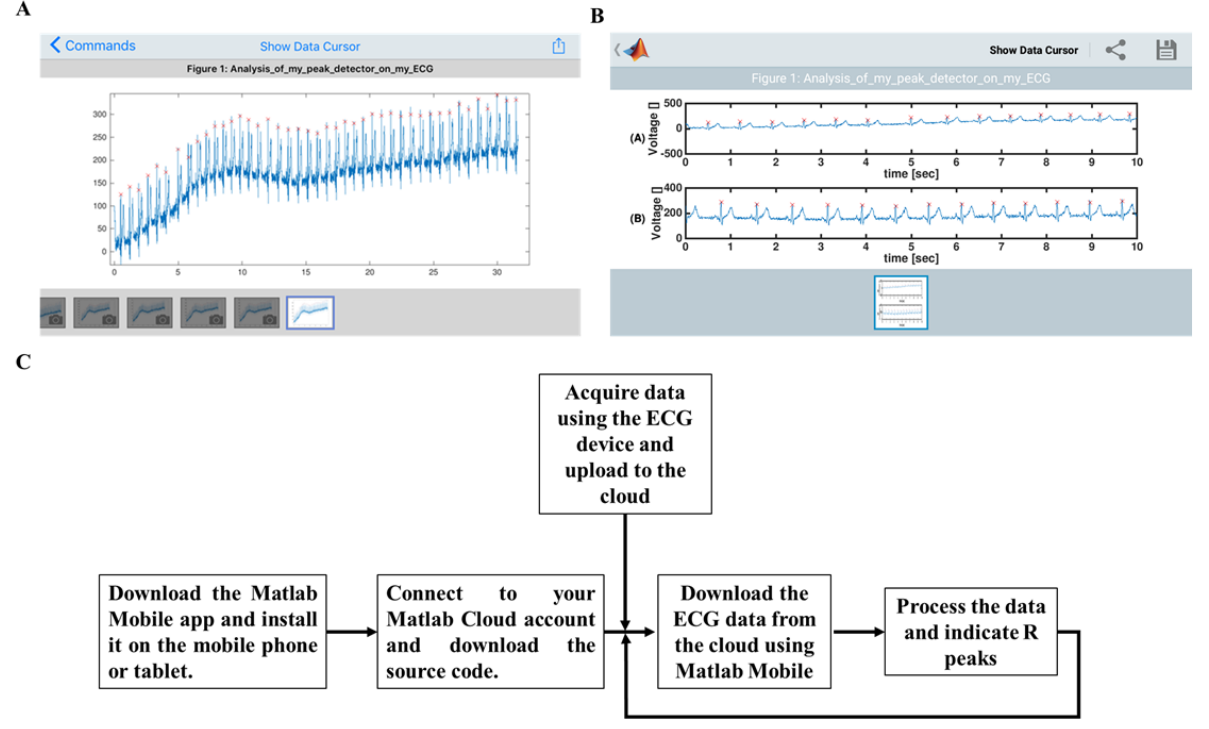
Figure 8. MATLAB Mobile graphic user interface with recorded data from Beecardia ECG device on (A) iOS and (B) Android systems. The “x” symbol represents R